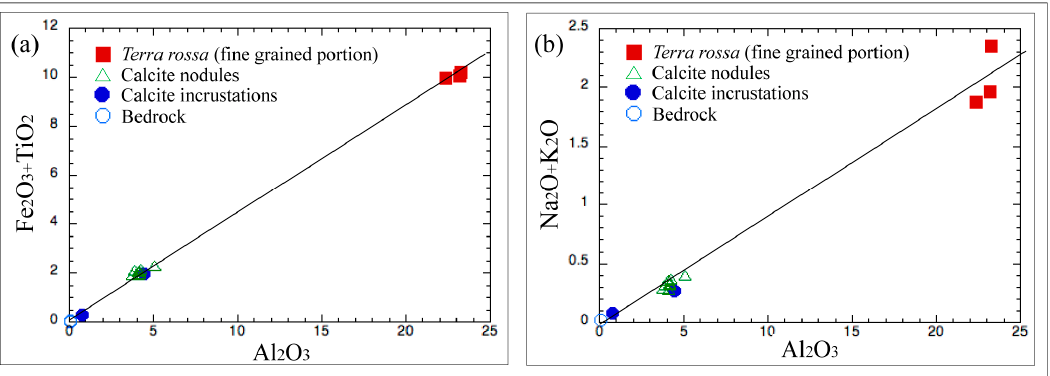
Figure 7. Binary diagrams: ( a ) Al 2 O 3 versus (Fe 2 O 3 + TiO 2 ) and ( b ) Al 2 O 3 versus (Na 2 O+K 2 O). To be tt er constrain the chemical features of karst products, one sample of the thickest incrustation, two samples of nodules and three samples of a fi ne-grained portion of terra rossa were analyzed for other trace elements and REE (Table 2).